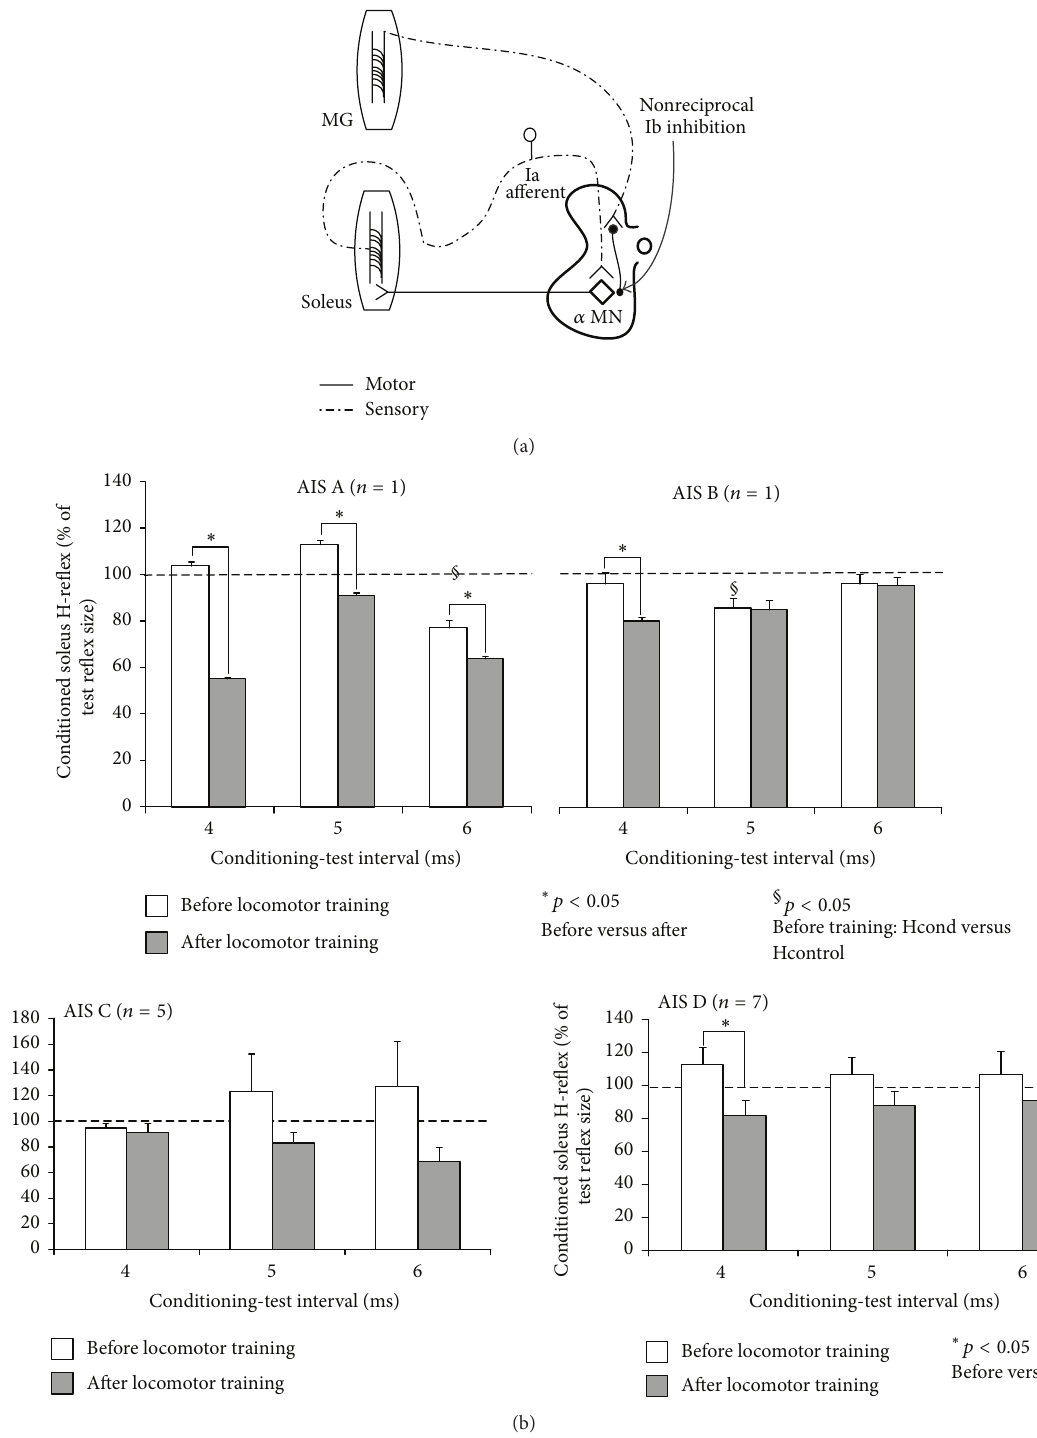
Figure 5: Functional reorganization of nonreciprocal Ib inhibition after locomotor training in SCI. (a) Schematic diagram of the neuronal pathway of nonreciprocal Ib inhibition mediated by a conditioning afferent volley induced by stimulation of the ipsilateral medialis gastrocnemius nerve at short conditioning-test (C-T) intervals. The facilitatory locomotor Ib pathway is not indicated. (b) Mean amplitude of the conditioned soleus H-reflex as a percentage of the unconditioned H-reflex recorded at each C-T interval tested before and after locomotor training from the right leg, grouped per AIS, in the seated position. ∗ 𝑝 < 0.05 indicate statistically significant differences of the conditioned H-reflexes recorded before and after locomotor training. Data adopted and modified from